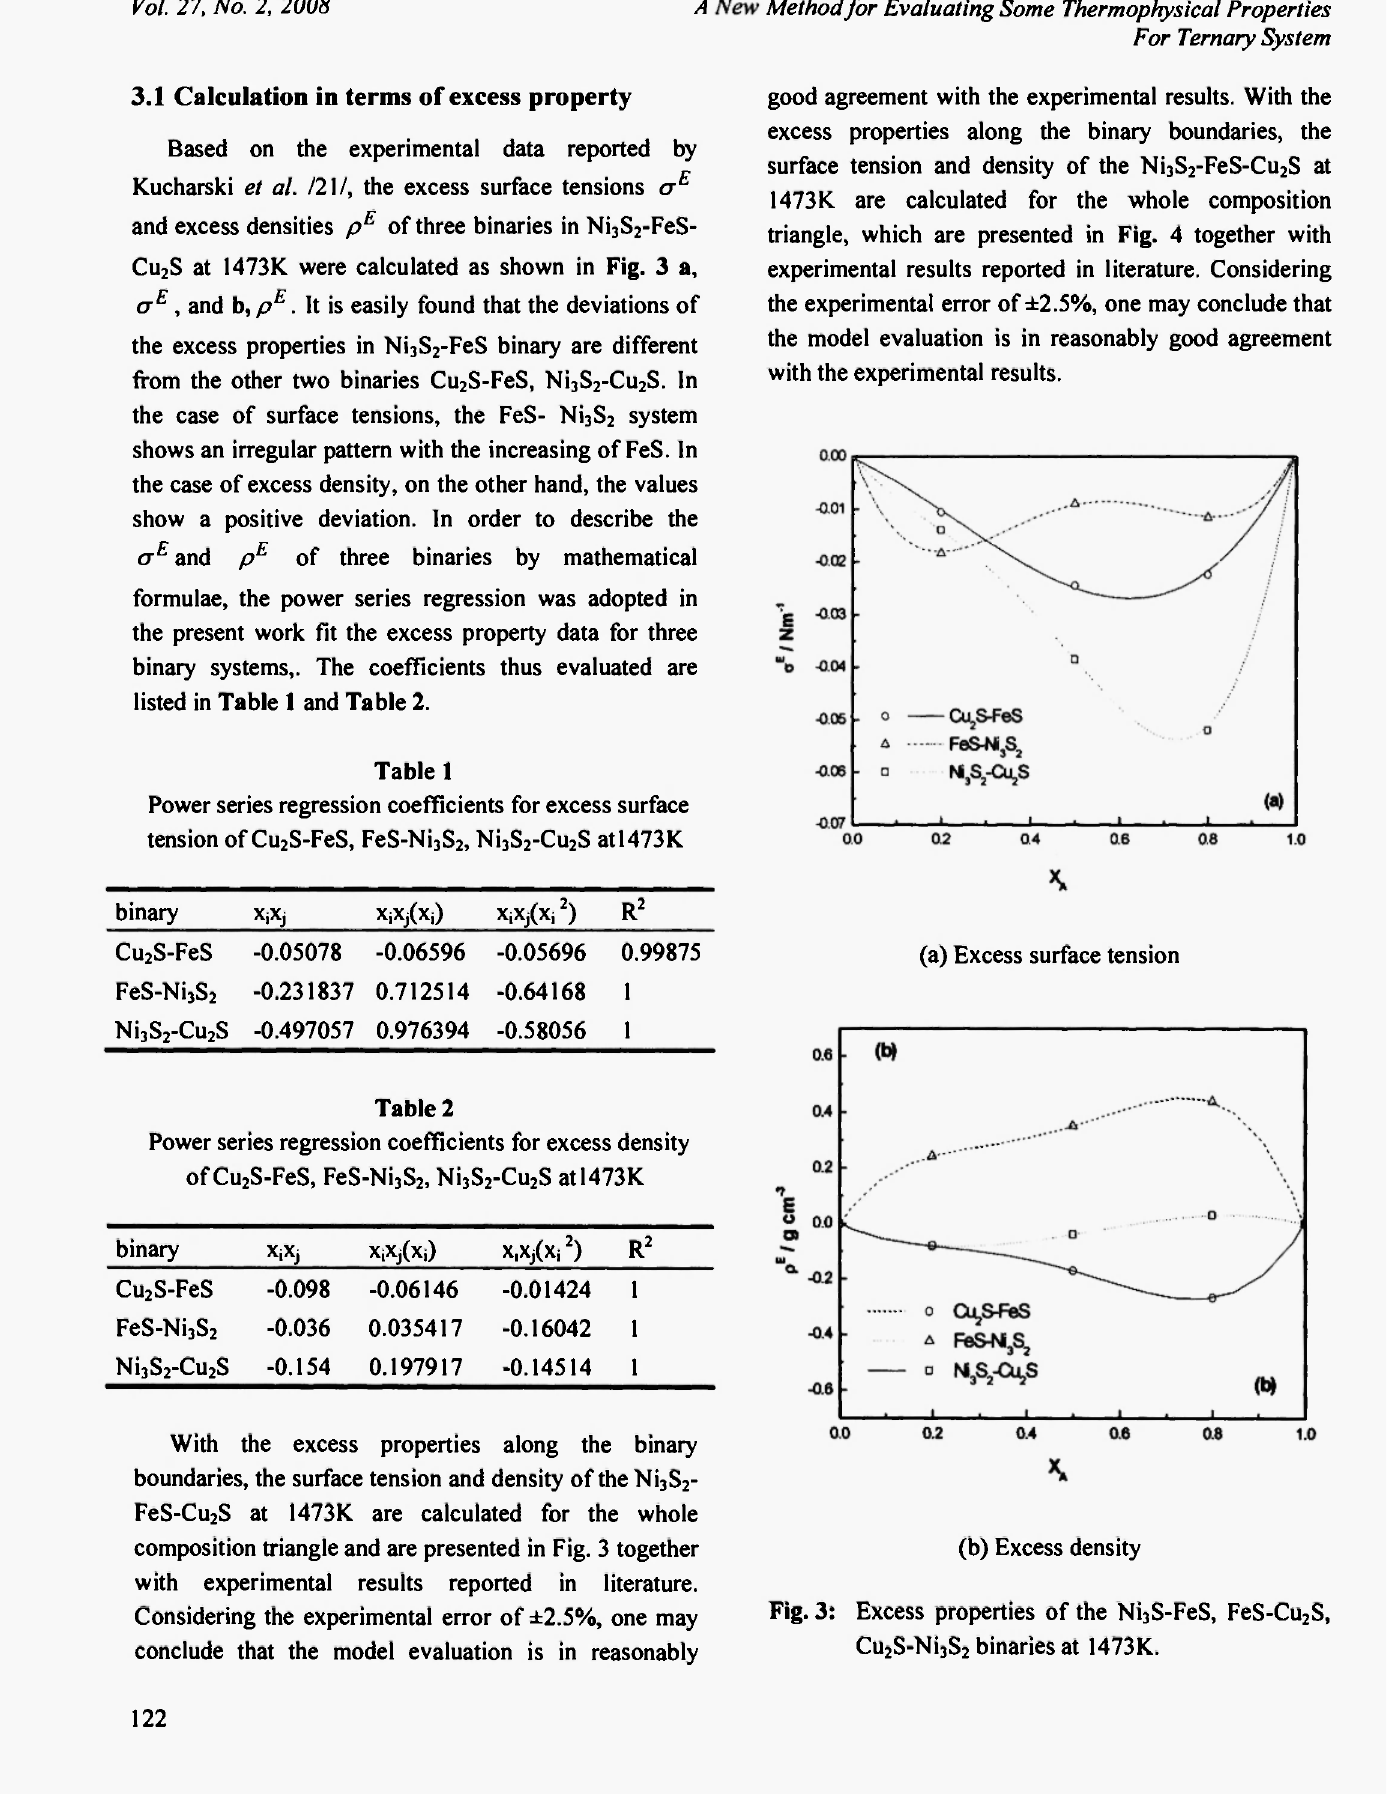
Fig. 3: Excess properties of the Ni 3 S-FeS, FeS-Cu 2 S, Cu 2 S-Ni 3 S 2 binaries at